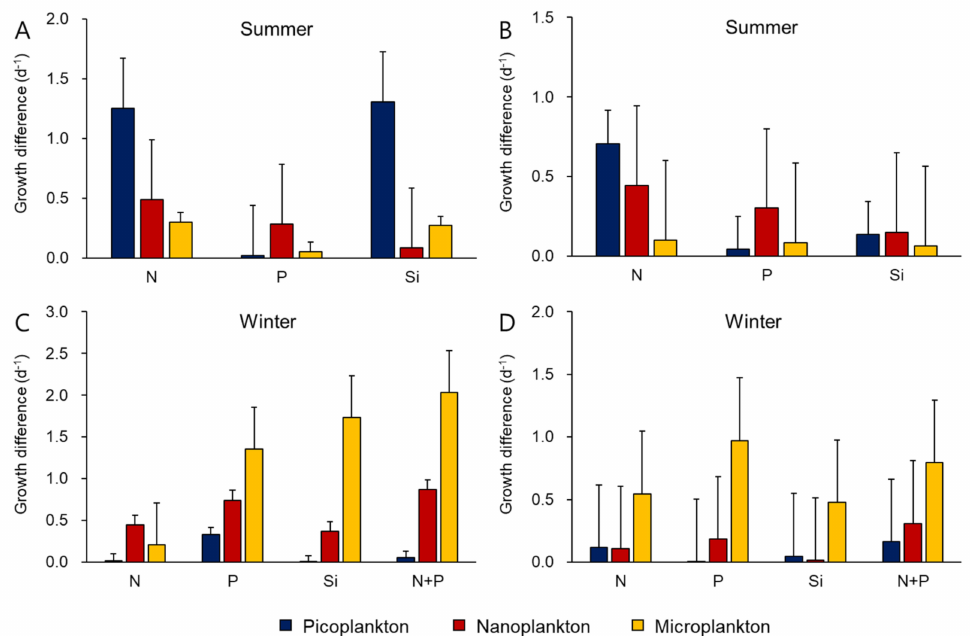
Figure 7. Growth differences (d − 1 ) of size-fractionated phytoplankton in response to nitrate, phosphate, silicate, and a combination of nitrate and phosphate. ( A ) Growth differences in the inner bay in the summer, ( B ) growth differences in the outer bay in the summer, ( C ) growth differences in the inner bay in the winter, and ( D ) growth differences in the outer bay in the winter. Abbreviations are as follows: N = nitrate, P = phosphate, Si = silicate, and N + P = the combination of nitrate and phosphate.